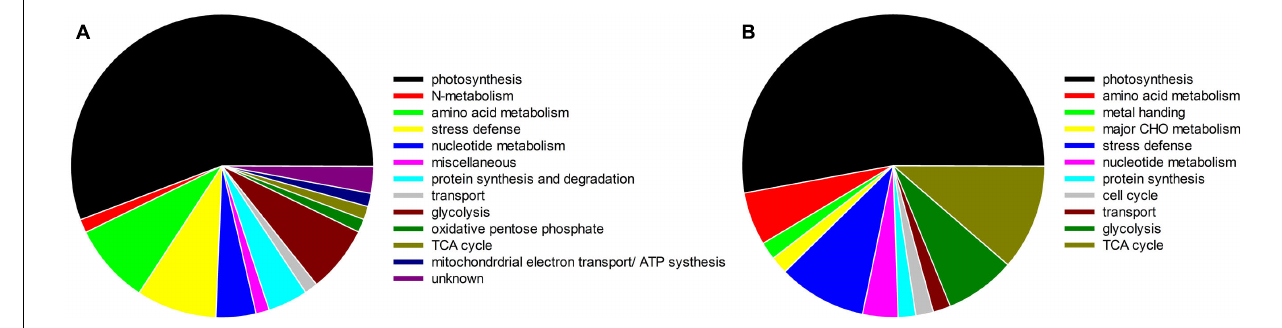
FIGURE 13 | Functional classification of CO 2 responsive proteins identified in bermudagrass grown under normal temperature (A) and heat stress (B) at 28 days of